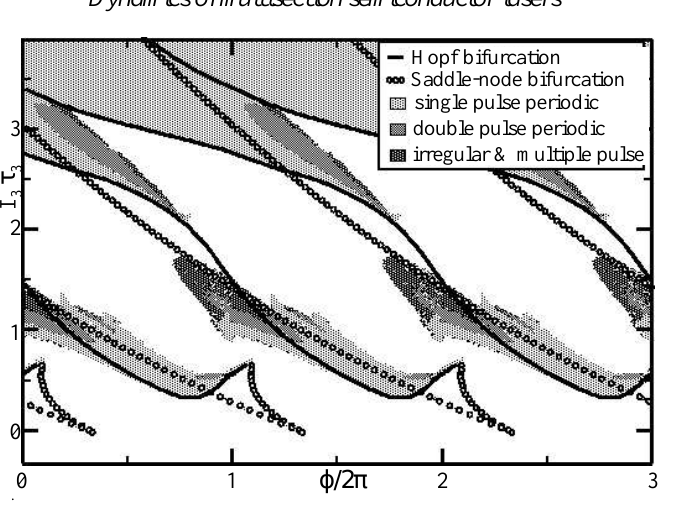
Figure 3. Parameter study of a three section laser by direct simulation of the PDE model with (cid:0)(cid:2)(cid:1)(cid:4)(cid:3)(cid:5)(cid:0) -tool. Full model and used parameter values (except of l 1 = 250 (cid:22) m, l 2 = 400 (cid:22) m and (cid:11) = 15 cm (cid:0) 1 ) can be found in